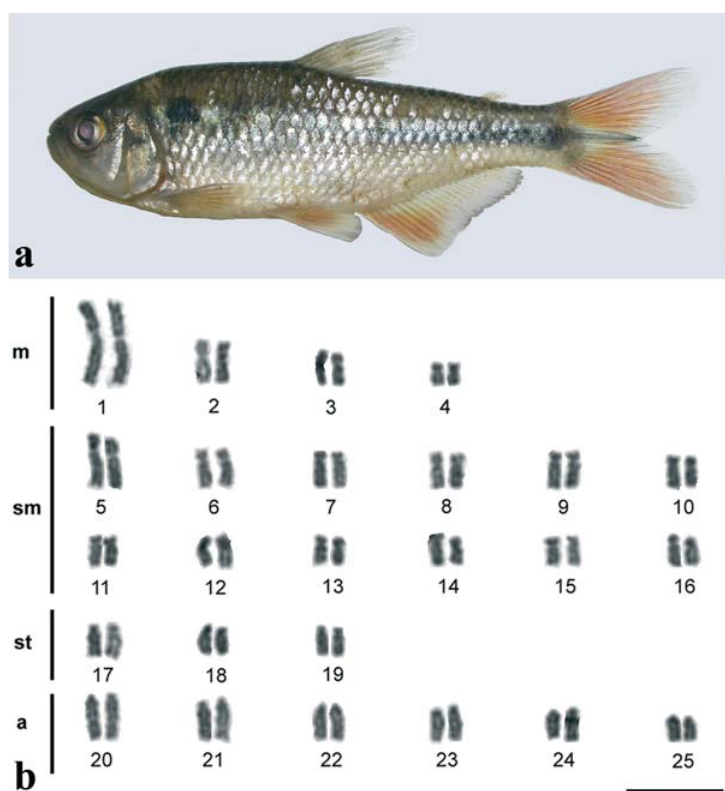
Fig. 1. Astyanax laticeps from the laguna dos Patos system. (a) specimen with 67.0 mm standard length; (b) Guiemsa stained karyotype. Bar = 5 µ